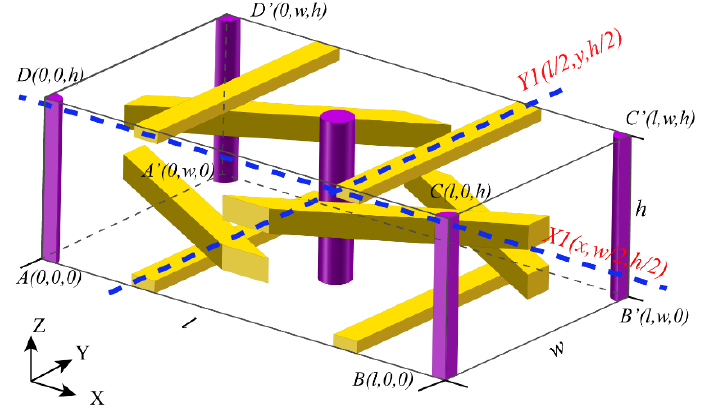
Figure 3. Topological relationship of the main yarns in UC1.